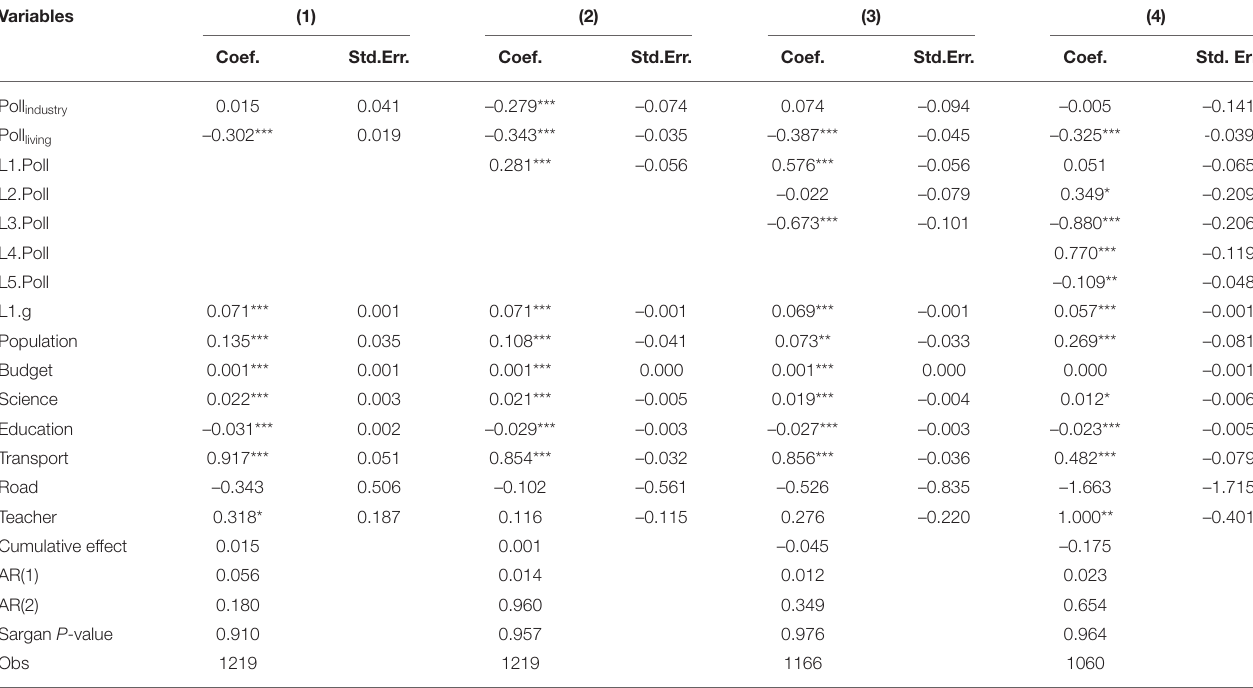
TABLE 6 | Results of dynamic estimation of the impact of industrial wastewater emissions on the volume of output growth.